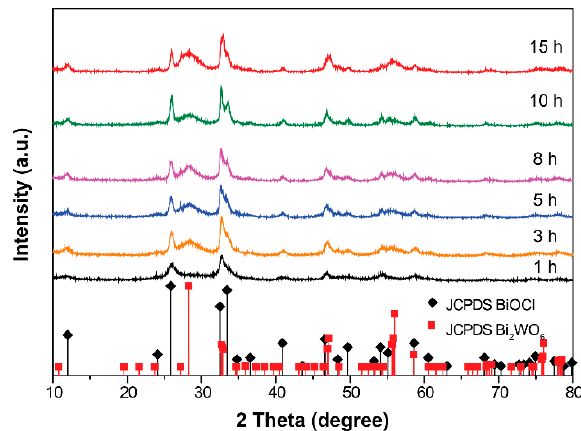
Figure 2. The evolution of XRD patterns of prepared samples as a function of hydrothermal reaction time.